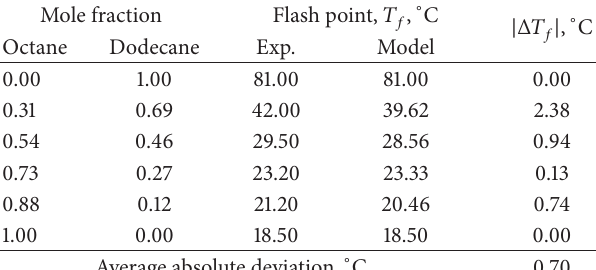
Table 5: Flash point of octane + dodecane with different mole fractions.